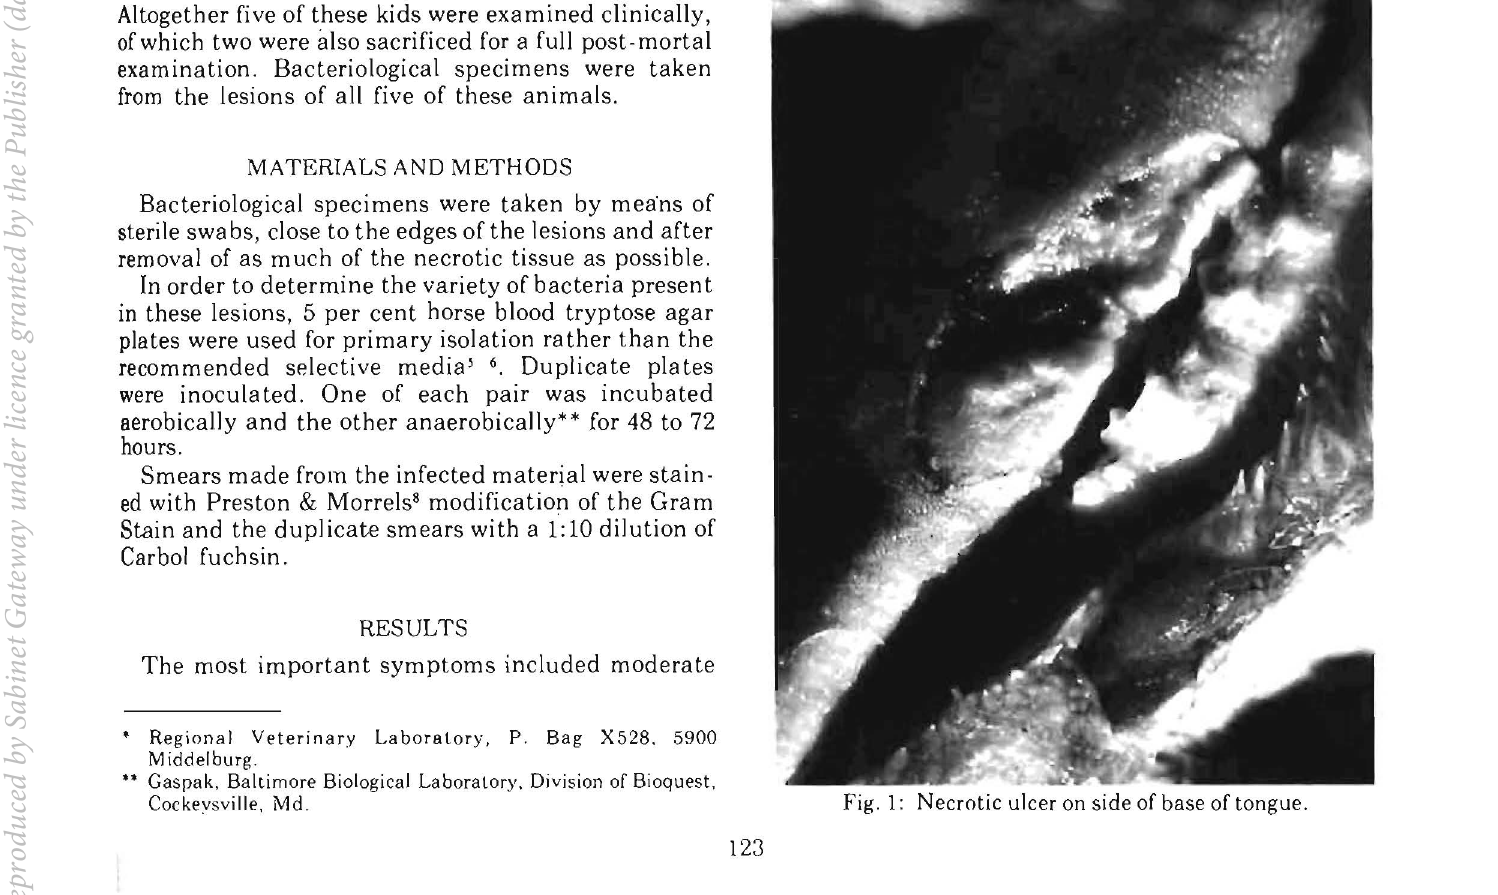
Fig. 1: Necrotic ulcer on side of base of